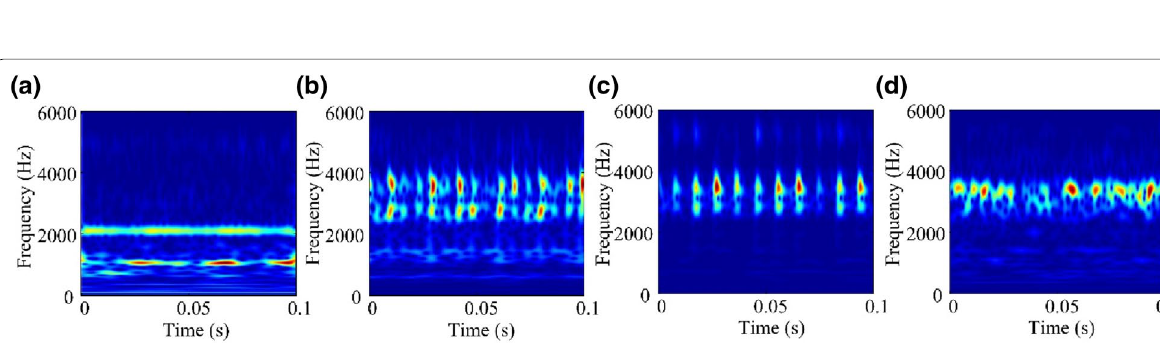
Figure 9 Time-frequency representation of raw signal using optimal GST: ( a ) normal, ( b ) IRF, ( c ) ORF, ( d ) BF